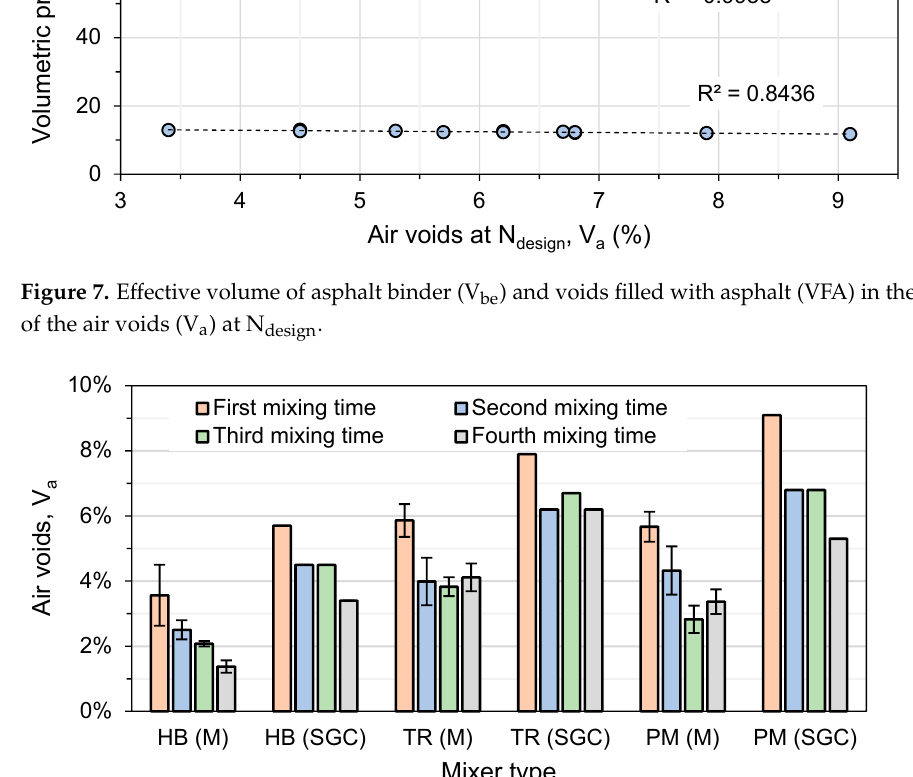
Figure 8. Voids with Marshall compaction (M) after 40 blows each side ( n = 6) and shear gyratory compaction (SGC) at N design ( n = 1).